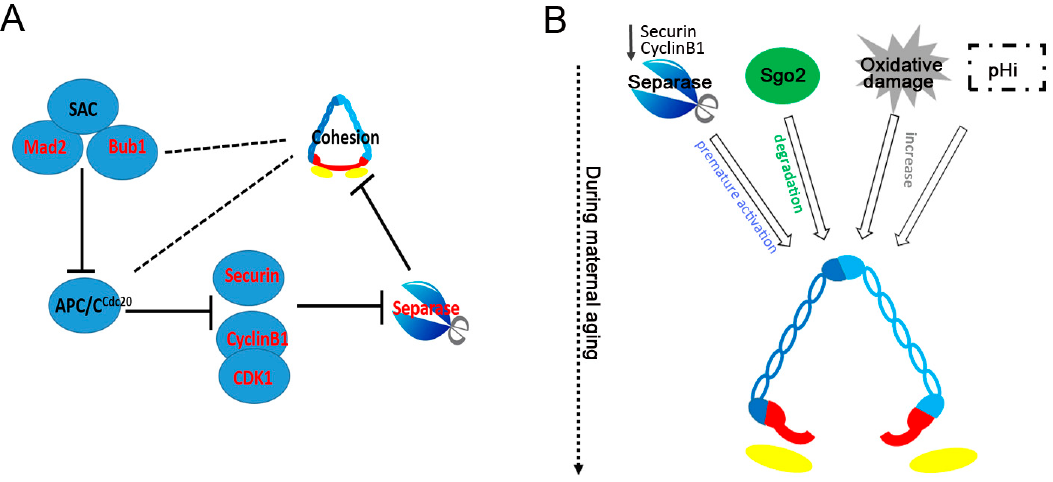
Figure 2. The cohesin-cleaving factors during maternal aging. ( A ) The correlation between spindle assembly checkpoint (SAC) and anaphase-promoting complex or cyclosome in association with Cdc20 (APC/C cdc20 ) and cohesion. The active SAC causes APC/C Cdc20 inactivation, which cannot degrade securin and cyclin B1 to cause the cleavage of cohesion structure and anaphase onset. Therefore, the SAC and APC/C cdc20 indirectly regulate the cohesion structure (indicated by broken line). Full line T shows the inhibitive effects of two factors; ( B ) Premature activation of separase, Sgo2 degradation, and the increase of oxidative damage and intracellular pH may be the leading cause of cohesion-ring structure cleavage during maternal aging.